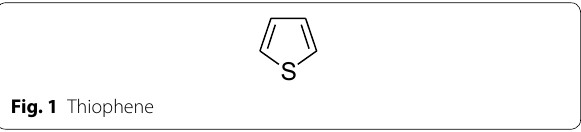
thiophene derivatives shows antimicrobial [6], anal- gesic and anti-inflammatory [7], antihypertensive [8], and antitumor activity [9] while they are also used